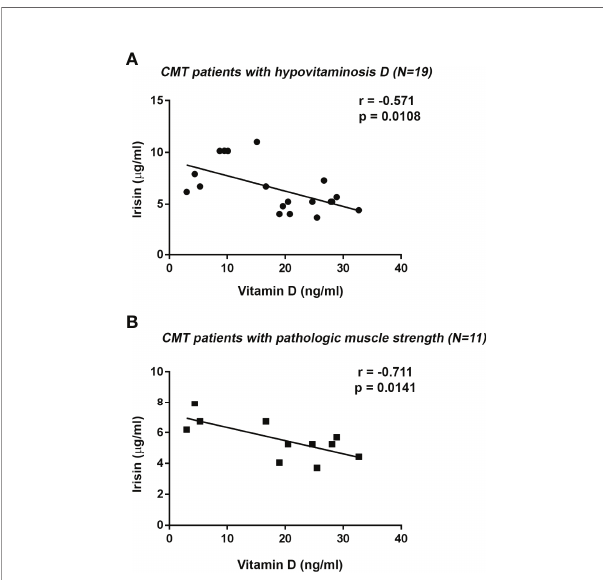
FIGURE 4 | Linear regression (r and p values as indicated) showing positive correlation between Irisin and the bone formation marker P1PN in all CMT patients (N=20) (A) and in CMT patients with normal muscle strength (N=9) (B) .